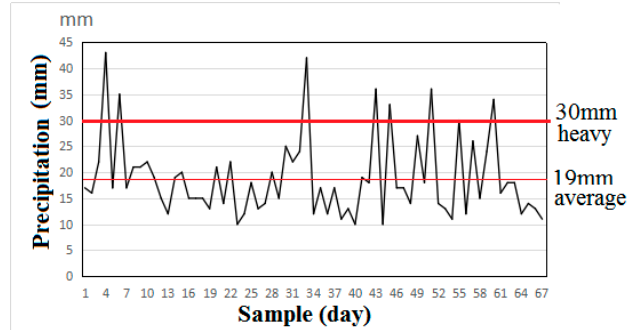
Figure 10. Daily strong precipitation time series in the wet season of 2002–2016 (December and